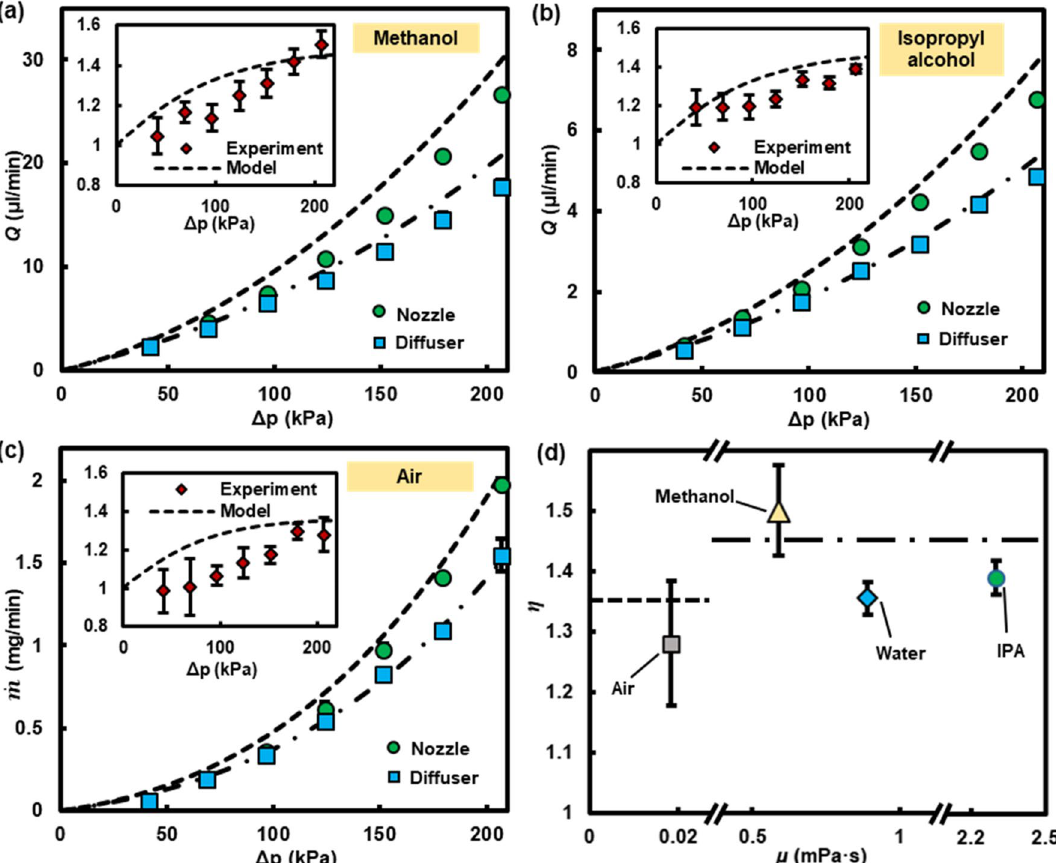
Figure 4. Volumetric flow rates, Q , of ( a ) methanol and ( b ) isopropyl alcohol as a function of pressure difference, (cid:31) p , across the deformable nozzle/diffuser microchannel ( W i , o m , of air as a function of (cid:31) p for the same microchannel. The dashed and dashed-dotted lines indicate flow rates, ˙ the results obtained from the fluid–solid-mechanics model for the deformable nozzle and diffuser, respectively. The insets show the rectification ratio, η , as a function of (cid:31) p . ( d ) η plotted as the fluid’s viscosity. The dashed and dashed-dotted lines represent the theoretical model for compressible and incompressible fluids,